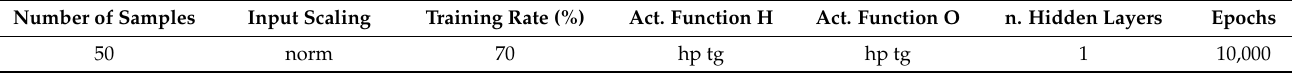
Table 5. Optimal architecture’s parametric set.